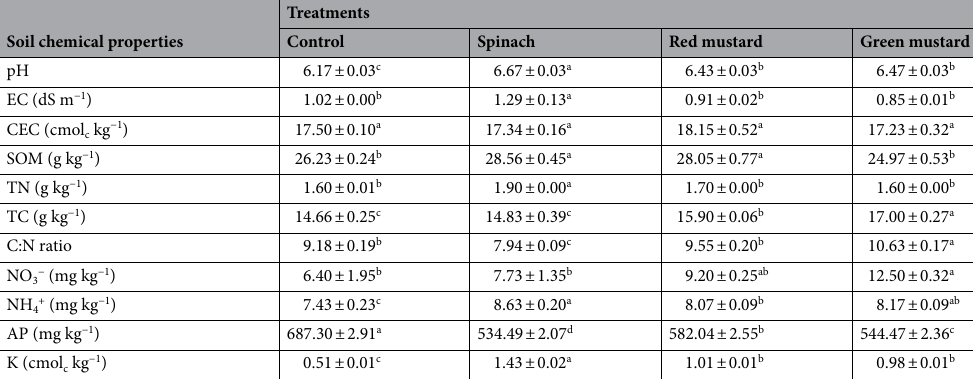
Table 1. Effect of different green manures on soil chemical properties. Control: without green manure amendment. EC Electrical conductivity, CEC cation exchange capacity, SOM soil organic matter, TN total nitrogen, TC total carbon, NO 3− nitrate nitrogen, NH 4+ ammonium nitrogen, AP available P 2 O 5 , K Exchangeable potassium. Mean values (n = 3) followed by different letter (s) in a row represent significant differences at p ≤ 0.05, DMRT